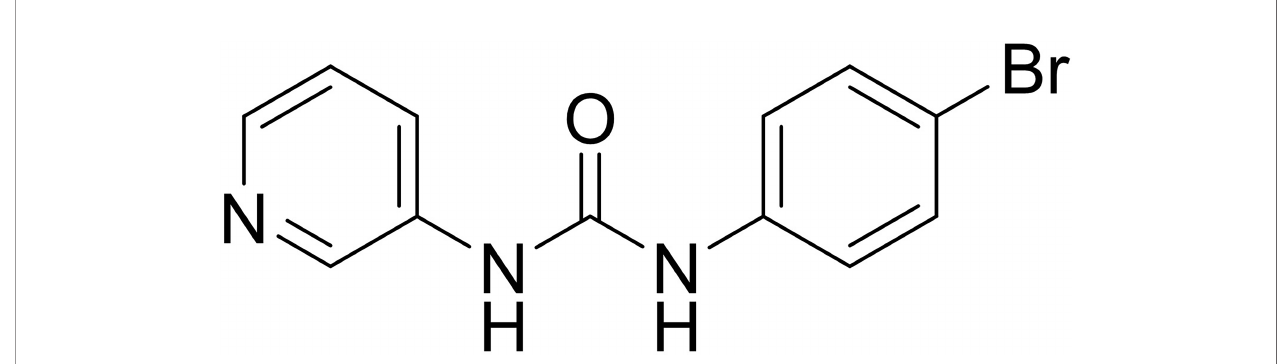
FIGURE 2 | The structure of SI-1, a novel inhibitor